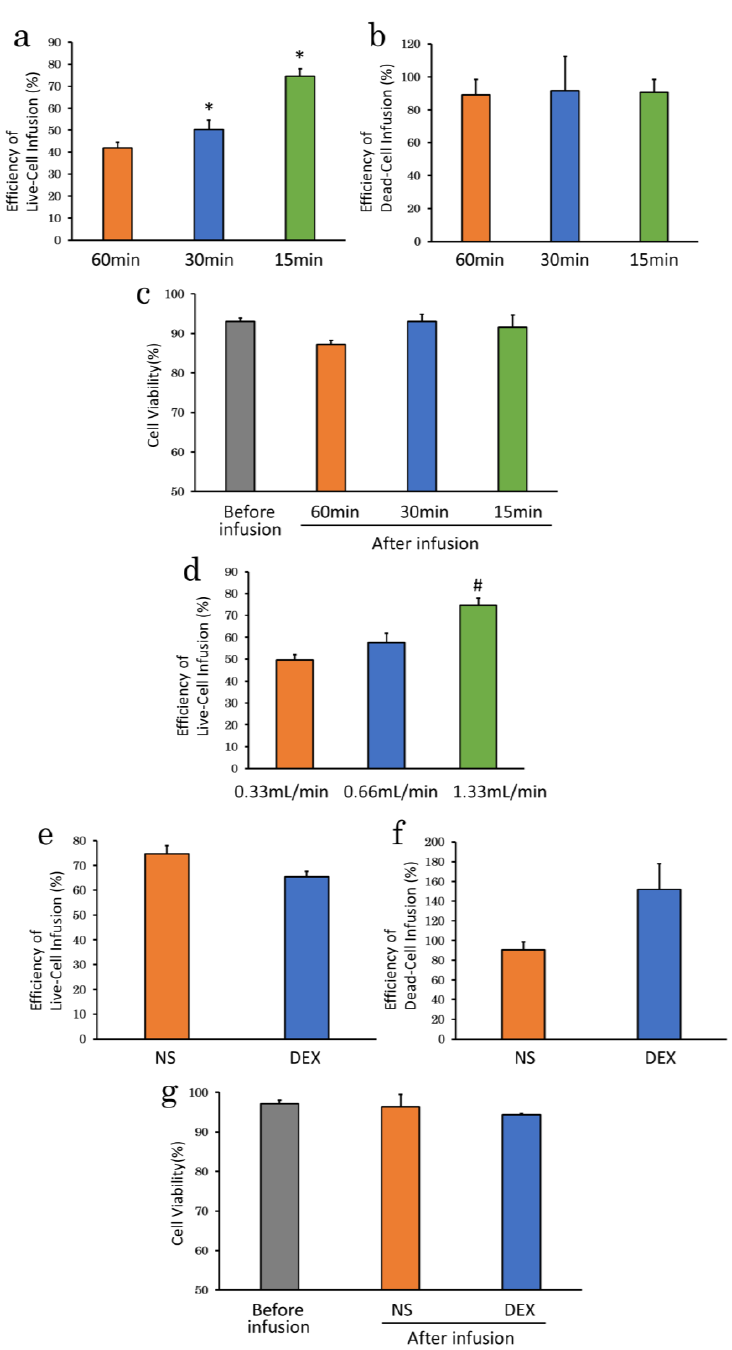
Figure 5. Infusion time experiments. ( a ), Efficiency of live-cell infusion for 15, 30, and 60 min infusions. Efficiency of live-cell infusion was significantly higher for 15 and 30 min than for 60 min; ( b ), Efficiency of dead-cell infusion did not differ among the three time groups; ( c ), Cell viability after infusion tended to be higher at 15 and 30 min; ( d ), Differences in efficiency of live-cell infusion by infusion rate. Faster infusion rates tended to result in higher efficiency of live-cell infusion; ( e ), Efficiency of live-cell infusion after 15 min infusion with different suspension solutions. In contrast to infusion over 60 min, efficiency of live-cell infusion tended to be better in NS; ( f ), Efficiency of dead-cell infusion after 15 min infusion with different suspension solutions. Efficiency of dead-cell infusion was high at DEX, exceeding 100%; ( g ), Cell viability after 15 min infusion with different suspension solutions. * p < 0.01 vs. 60 min. # p < 0.05 vs. 0.33 mL/min. NS: normal saline;